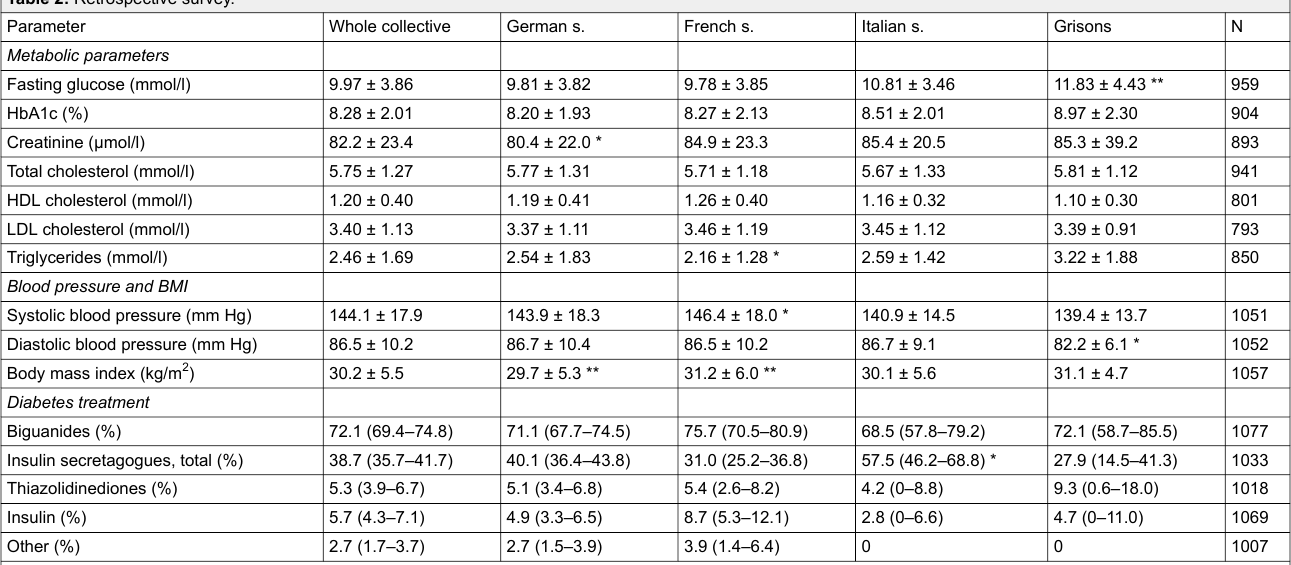
Table 2: Retrospective survey.